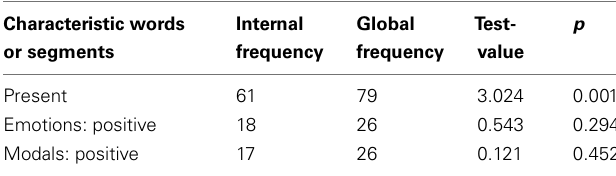
attributed to the voice of